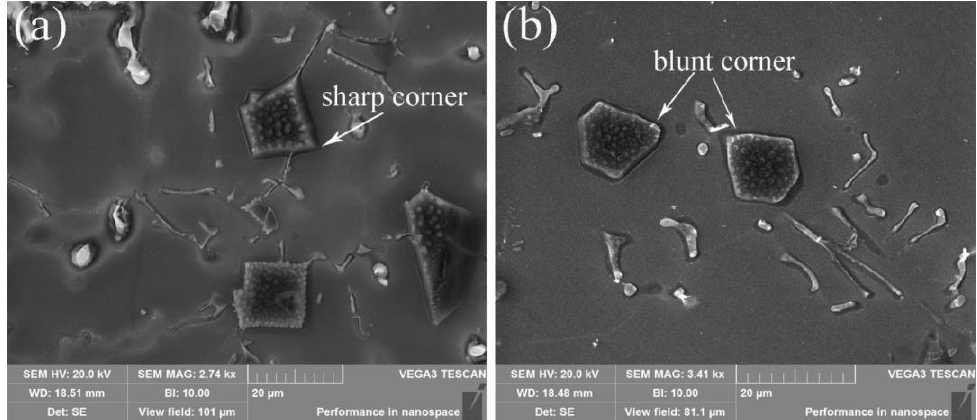
Figure 6. SEM micrographs of the primary Mg 2 Si phases in the ( a ) as-cast composites and ( b ) solution-treated composites.